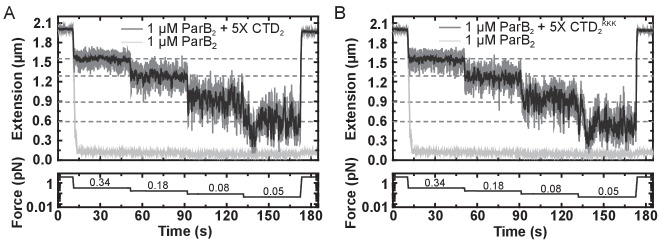
The CTD of ParB both inhibits and disrupts ParB-dependent DNA condensation.(A) Representative traces of condensation assays for ParB in the presence and absence of excess free CTD. The expected DNA extension in the absence of ParB at each force is indicated by the dashed lines. (B) As in A, but using the CTDKKK variant in place of the CTD.